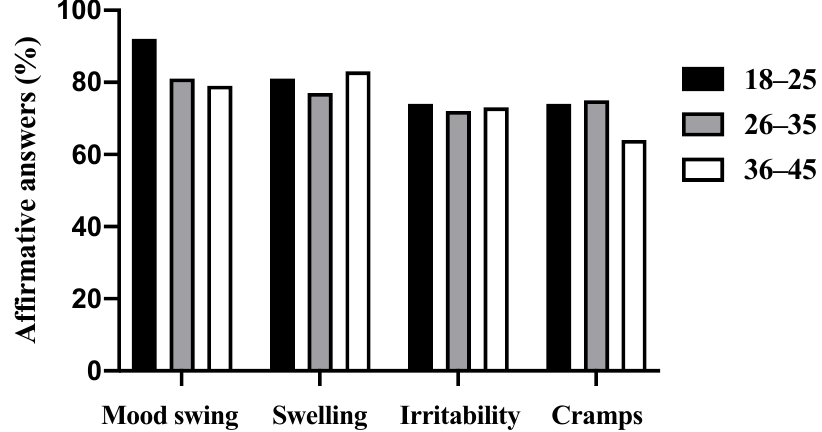
Figure 1. Four most-cited menstrual cycle symptoms according to age-group.